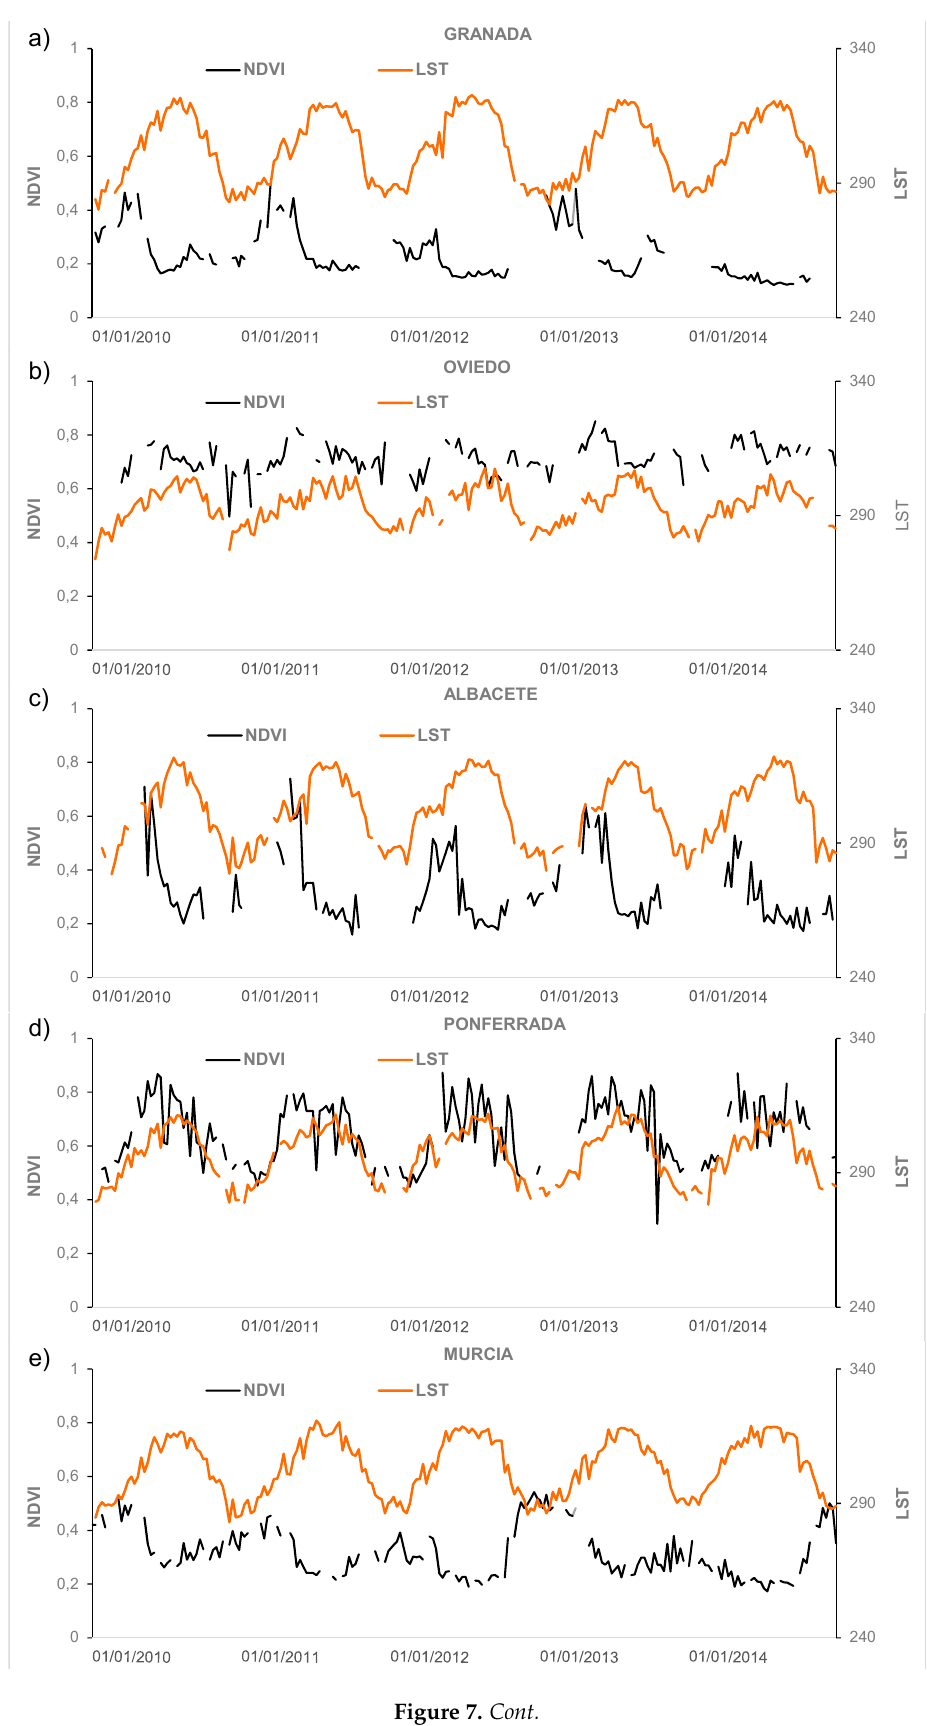
Figure 7. Cont. Figure 7.